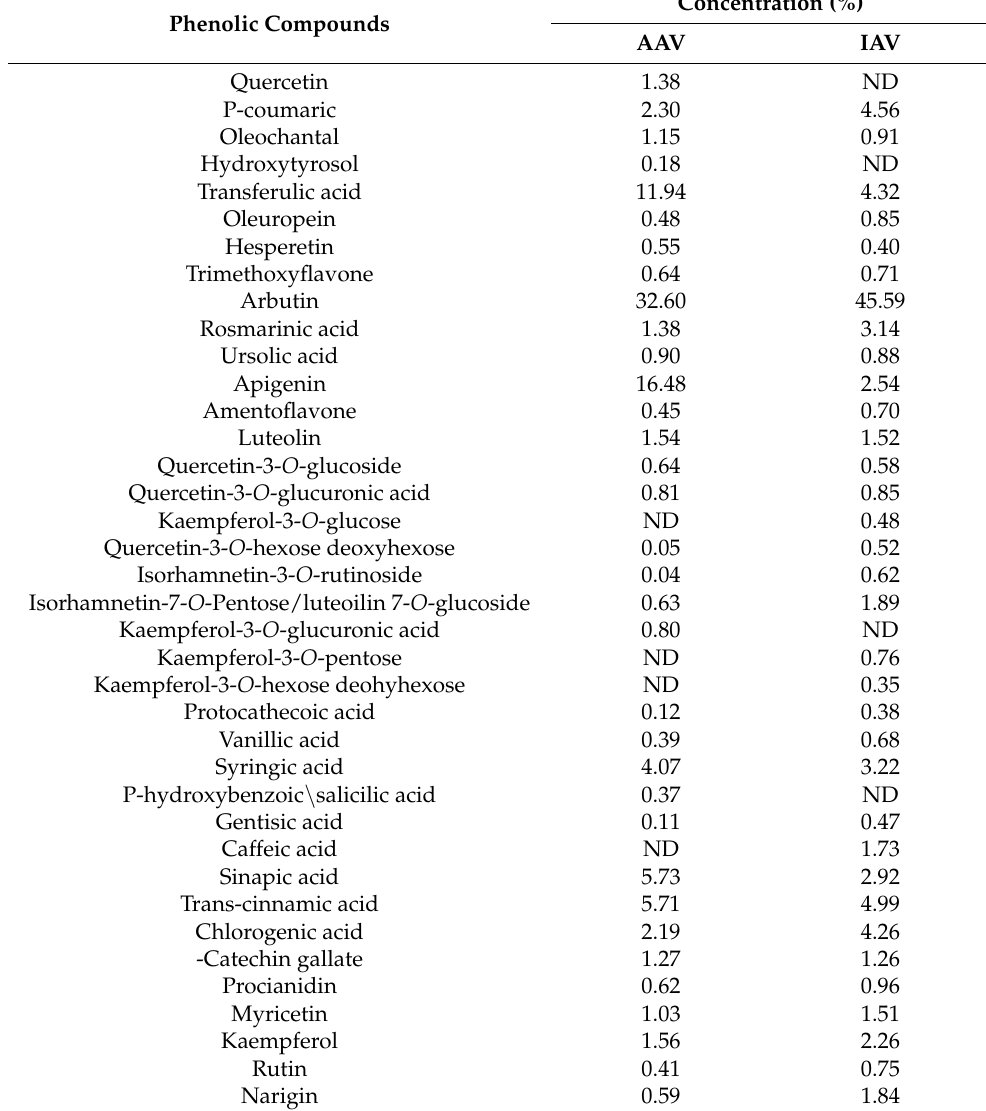
Table 5. Phenolic compounds of apple vinegar